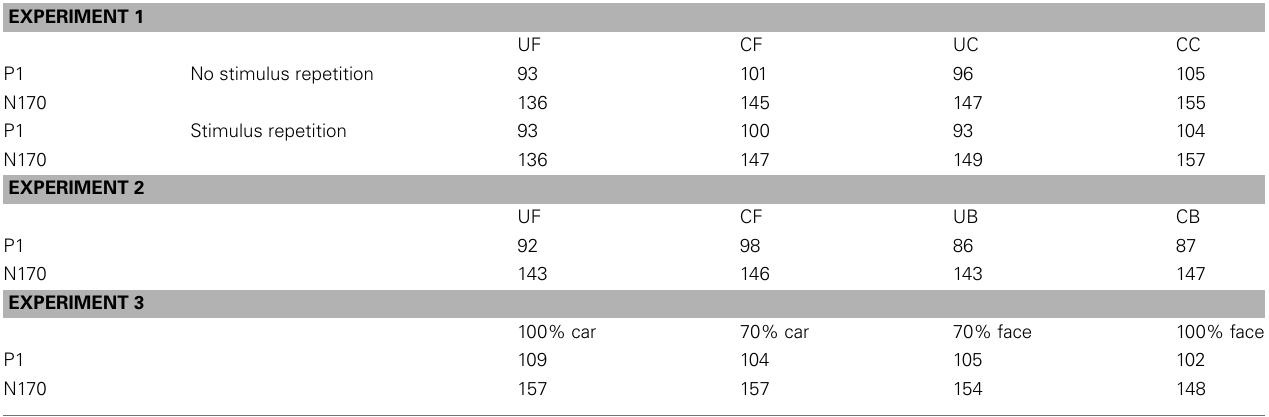
Table 1 |Average P1 and N170 peak latencies (in milliseconds) in Experiments 1, 2, and 3. EXPERIMENT